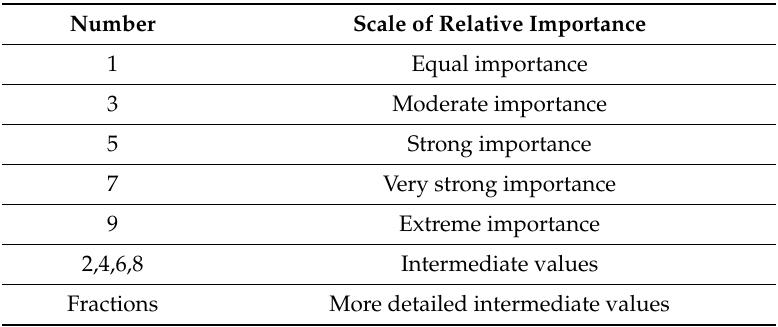
Table A5. Scale of relative importance for 1 to 9.